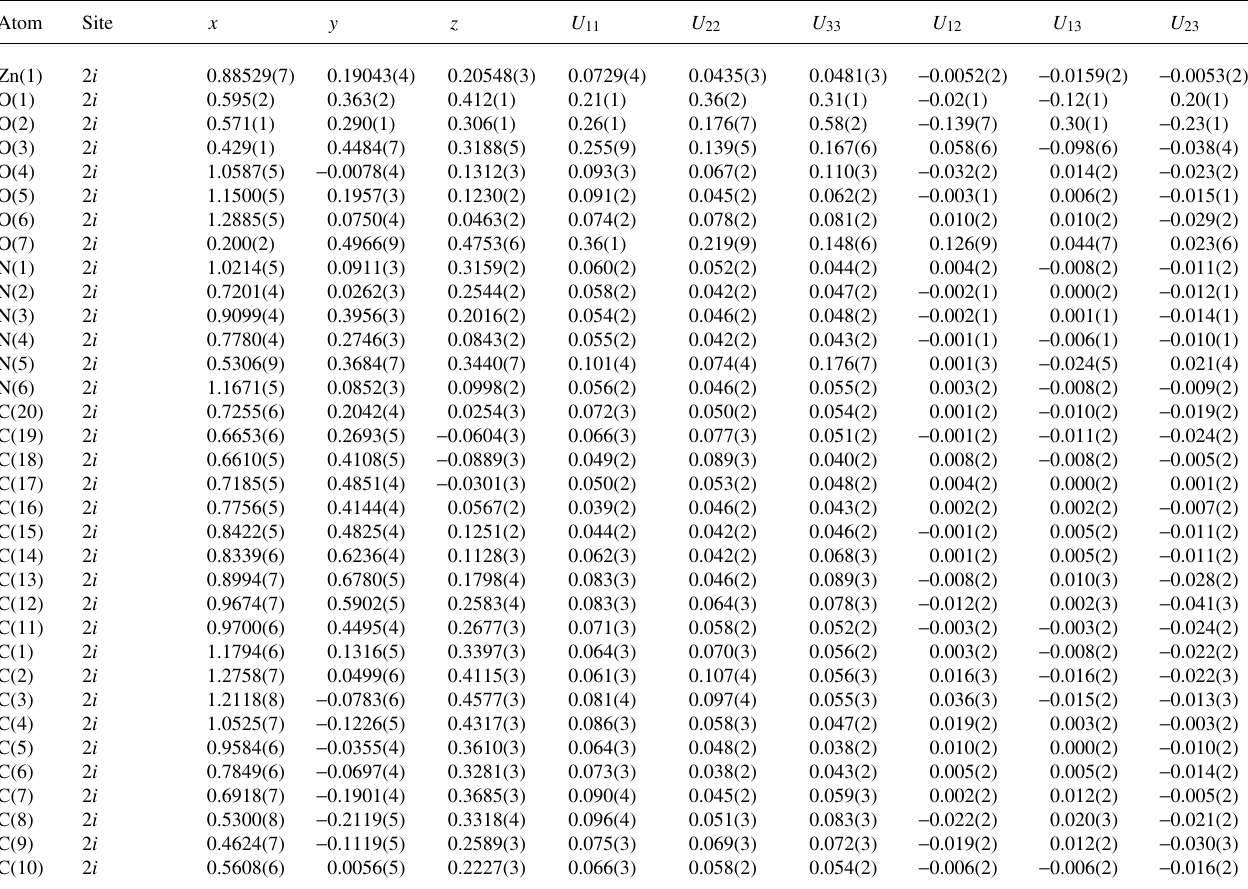
Table 3. Atomic coordinates and displacement parameters (in Å 2 )